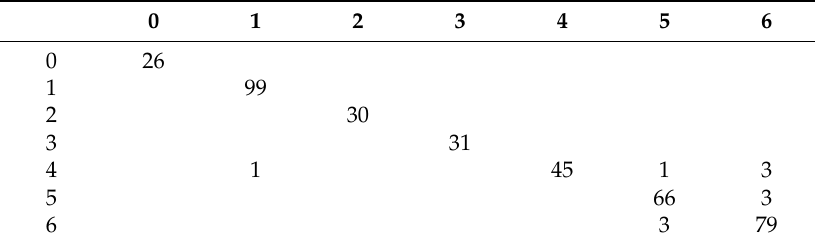
Table A4. The confusion matrix of Figure